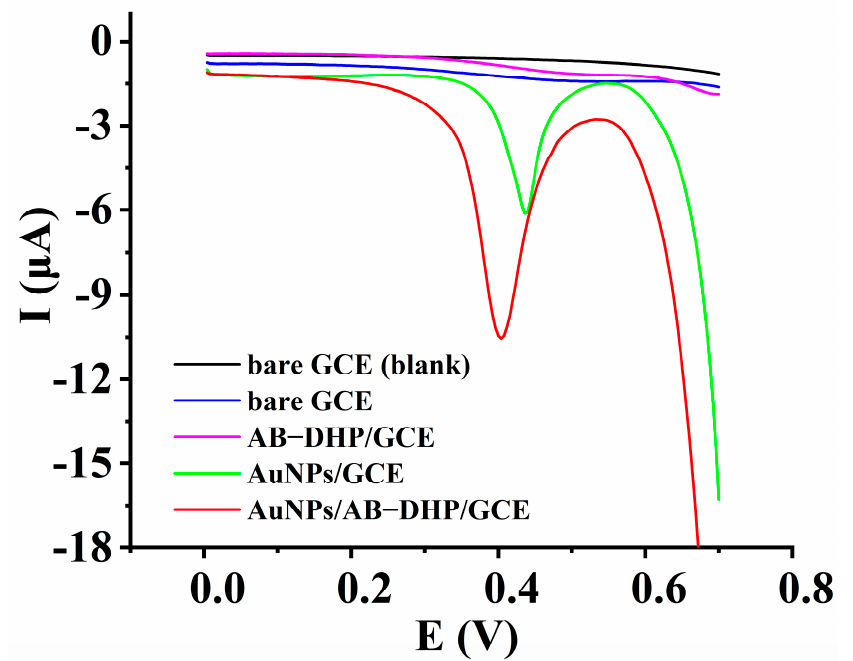
Figure 2. Differential pulse voltammograms between 0 µ M and 200 µ M HcySH on different electrodes in 0.15 M PBS (pH = 6.0).